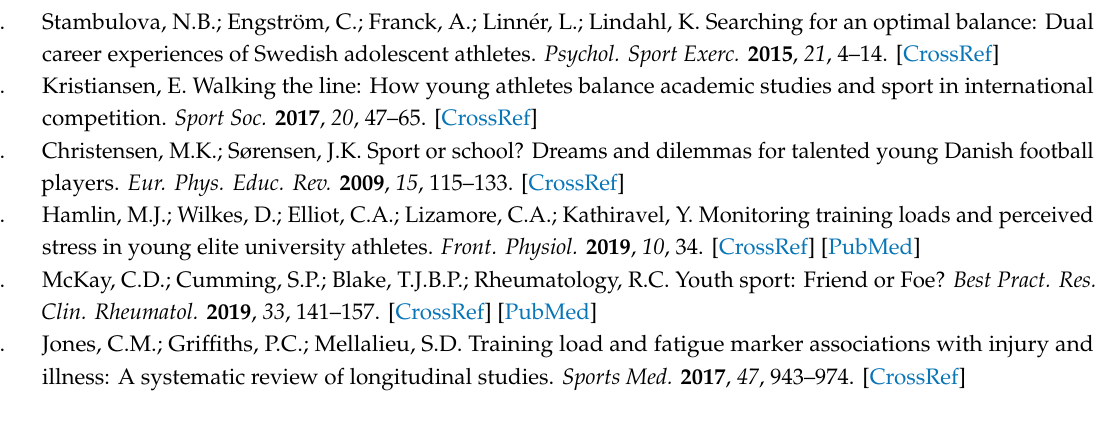
Table S1: Score values of on the factors for the di ff erent groups; Table S2: Score values of the factor predictors for the di ff erent groups; results of the preliminary pilot testing; results of the preliminary pilot testing with new model with “BY” statement; Mplus Code; source